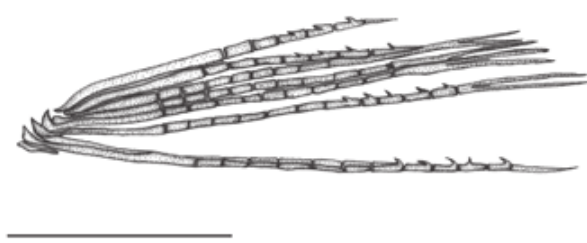
Fig. 5. Tyttocharax metae , paratype, IUQ 2343, adult male, 18.4 mm SL. Pelvic-fin rays illustrating distribution of pelvic- fin hooks, left side, ventro-medial view. Scale bar = 1 mm.